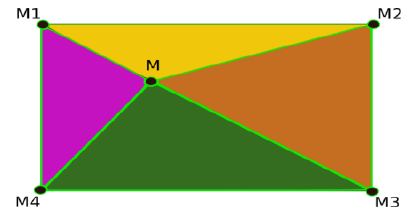
Figure 6 – Point M inside the rectangle